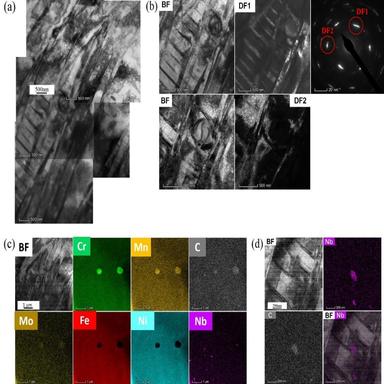
(a) Panoramic bright field TEM images showing the microstructure of alloy 709 subjected to a tensile test at 500 C. (b) Bright field and corresponding dark field TEM images showing the dislocation cells/walls formed during tensile deformation at 500 C. (c) Elemental Maps showing the (Cr, Mn)-rich carbides and Nb-rich MX precipitates (d) higher magnification micrograph showing deformed Nb-rich MX precipitates.